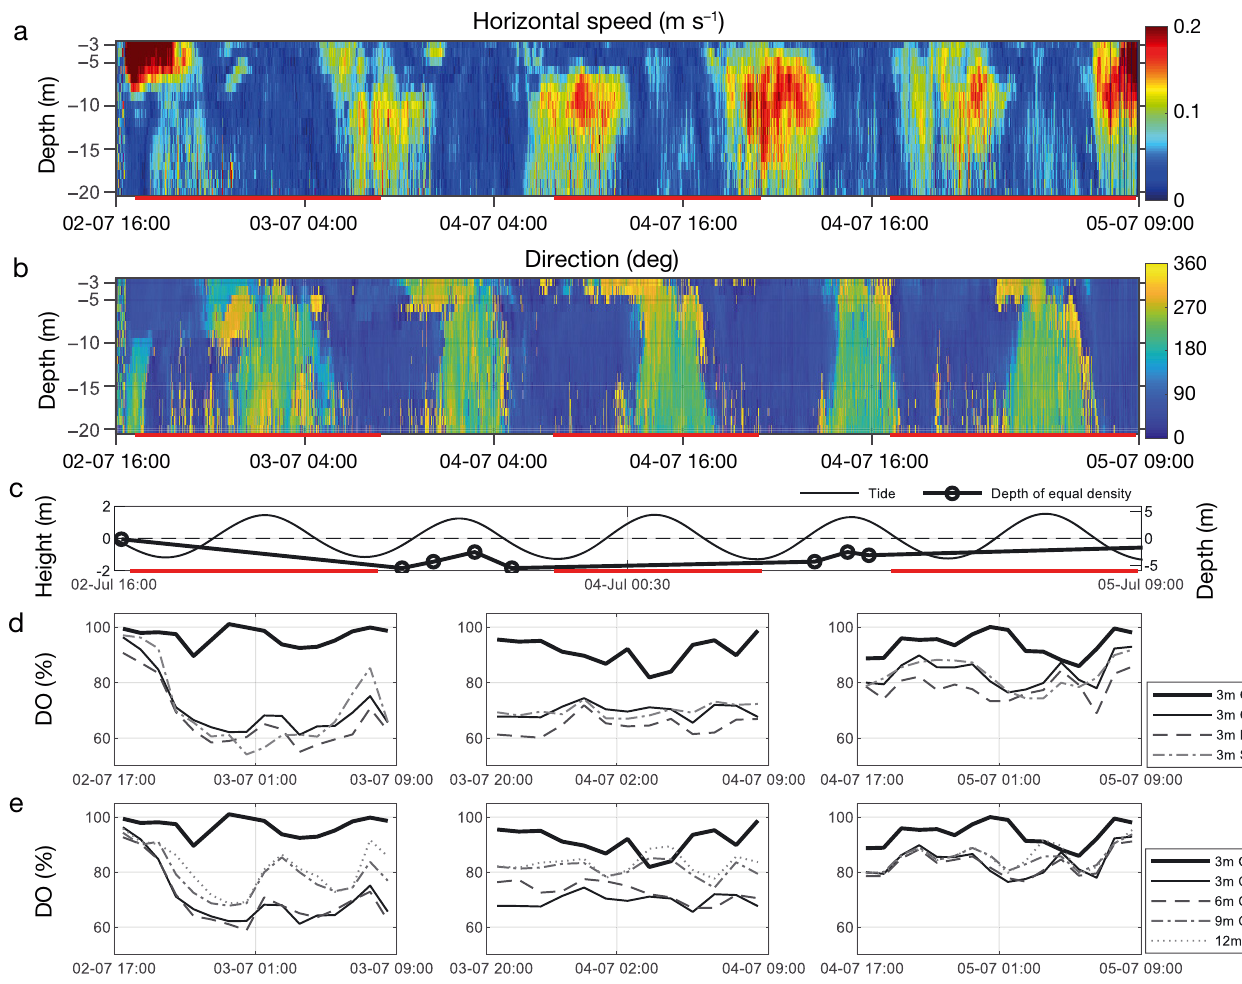
Fig. 6. (a) Current speed and (b) direction at Fornes in the top 20 m of the water column, measured by the DCP in position B (see Fig. 1) from 02 to 05 July 2019. Note that the measurement at 02 July 16:00 h between 3 and 10 m is potentially noise from a nearby boat. The red horizontal line along the x -axis indicates the period where DO measurements were taken. (c) Expected tidal height (thin black line) and the depth at which the density inside and outside the cage was equal (see Fig. 7 for density graphs); it should be noted that on 3 and 4 July, 2 and 1 additional CTD measurements, respectively, were included which are not represented in Fig. 7, as they were deemed redundant. (d,e) Hourly median DO for all oxygen sensors at Fornes for the periods marked with red. (d) Median for all sensors placed at 3 m depth, both outside and inside the cage. (e) Median for all sensors placed in the center of the cage, in addition to the one sensor placed outside the cage. O: outside; N: north; S: